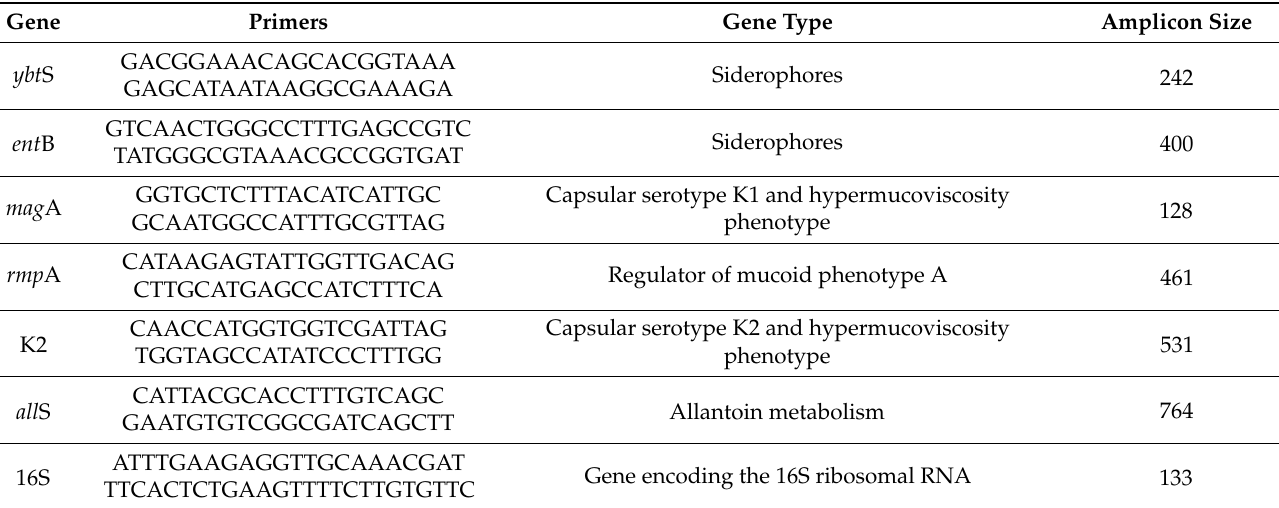
Table 1. Primers for genes encoding virulence factors of Klebsiella